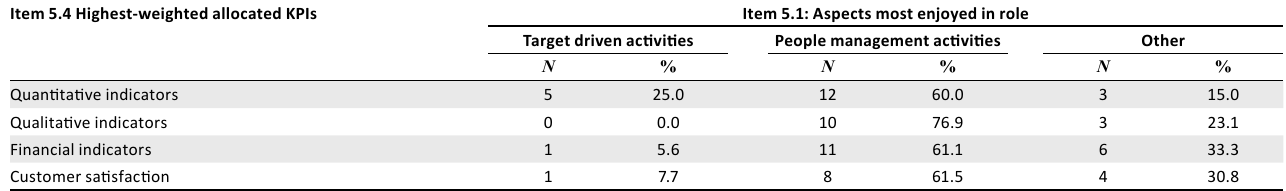
TABLE 13: Cross tabulation of the aspects managers enjoyed most and the highest-weighted allocated KPIs